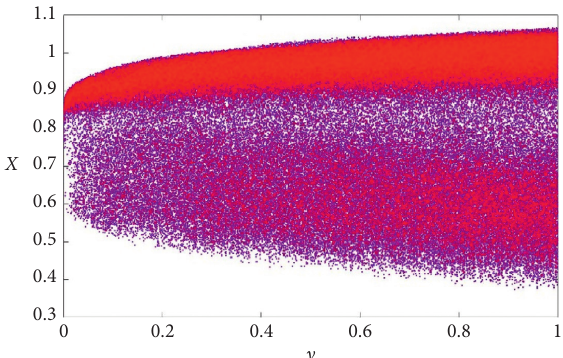
Figure 15: Bifurcation diagram of system (7) for θ � 1 . 30 and η � 0 . 1 with the blue plots showing the forward continuation (increase the parameter 0 ≤ c ≤ 1) and the red plots showing backward